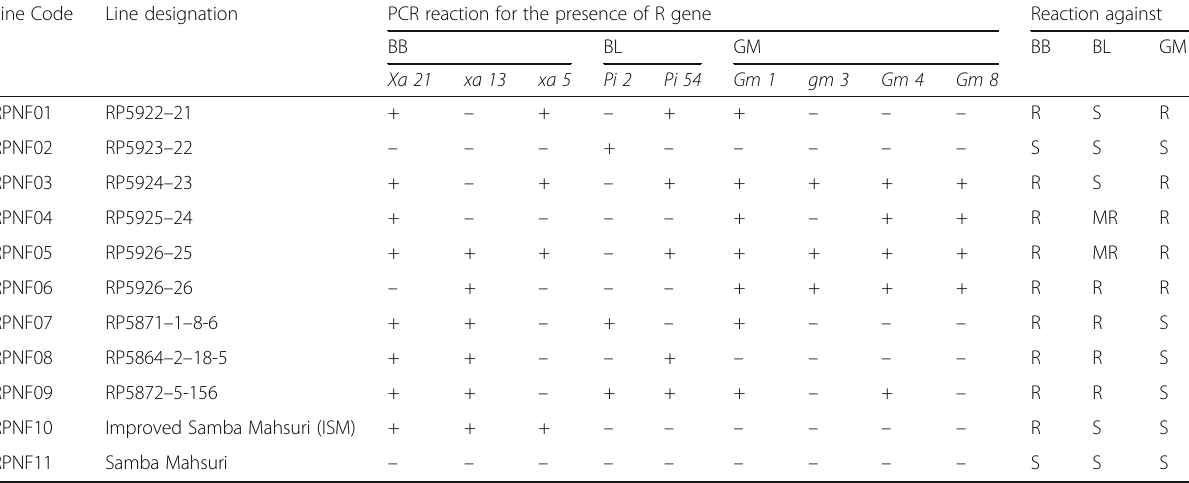
Table 1 Rice lines with multiple R genes selected for the study and their reaction to the target pests under